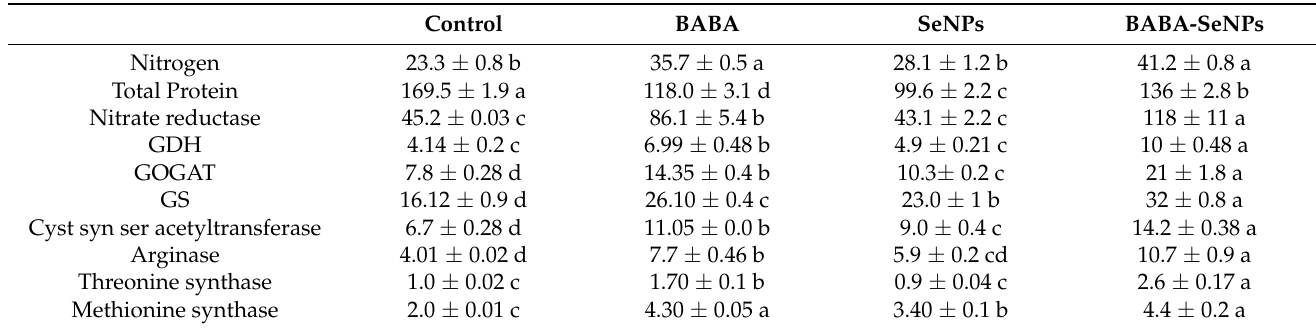
Table 4. Nitrogen (g 100 g − 1 FW), protein content (g 100 g − 1 FW), and nitrogen-related enzymes (umol mg − 1 protein. min) of control and BABA- and/or SeNPs-treated M. interexta sprouts. Data are represented by the means of four replicates ± standard deviations. BABA